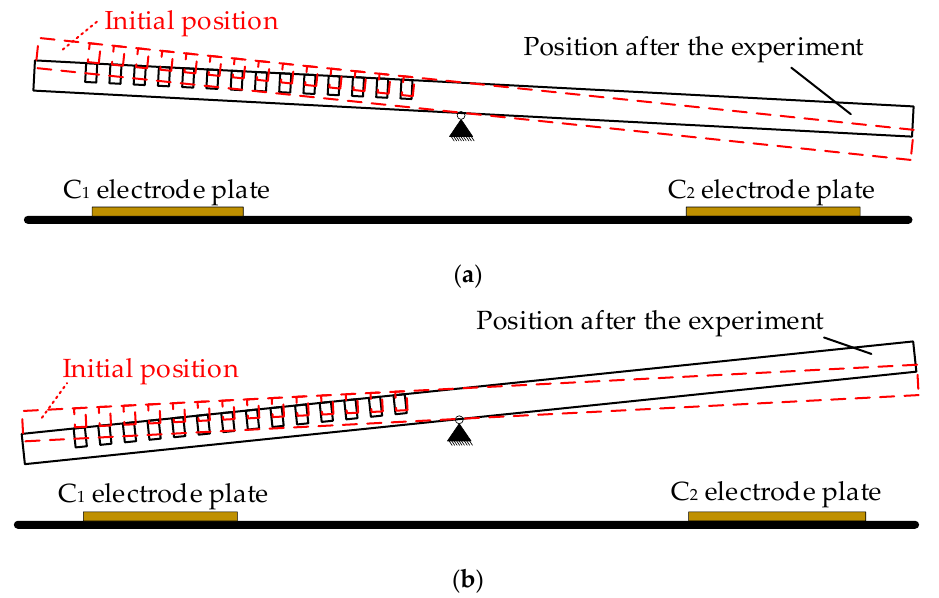
Figure 11. Schematic diagram of the position of the proof mass: ( a ) Sample #4; ( b ) Sample #5.